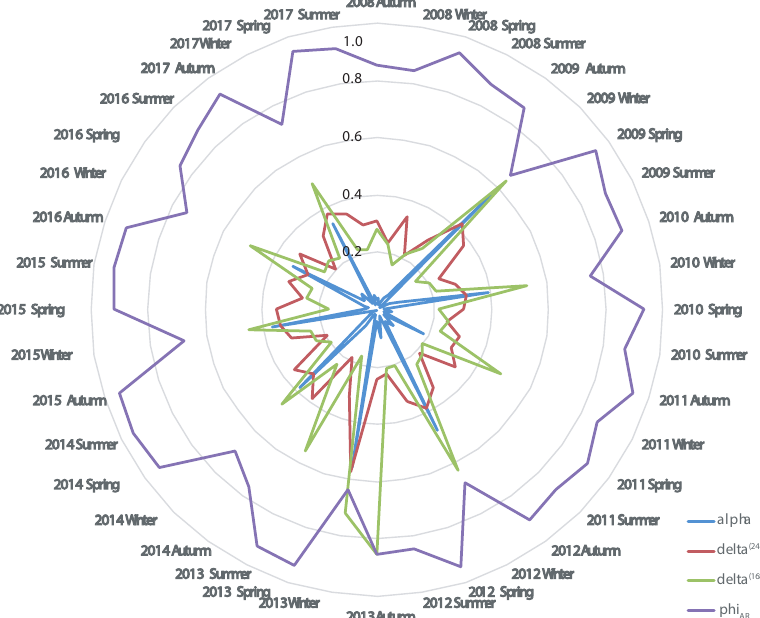
Figure 3. Radar diagram of the average of the parameters for the model NMC 24,168 depending on the